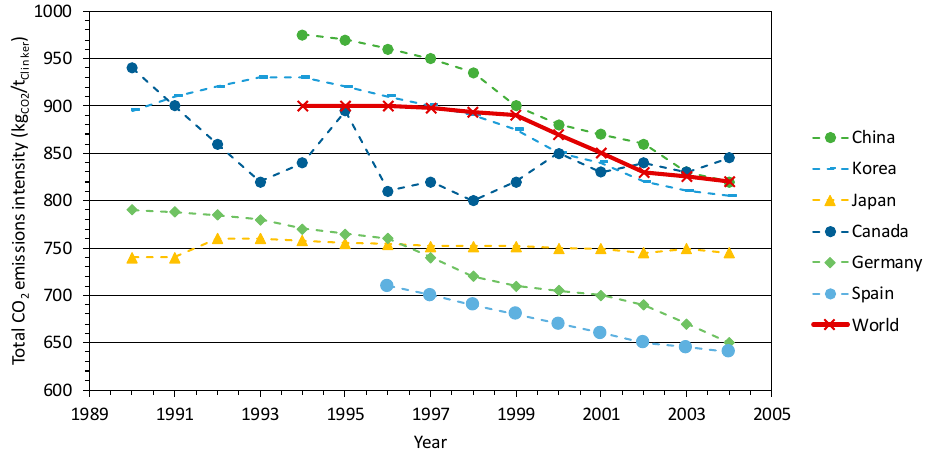
Figure 7. CO 2 emissions due to the calcination process and the combustion per ton of cement in some countries